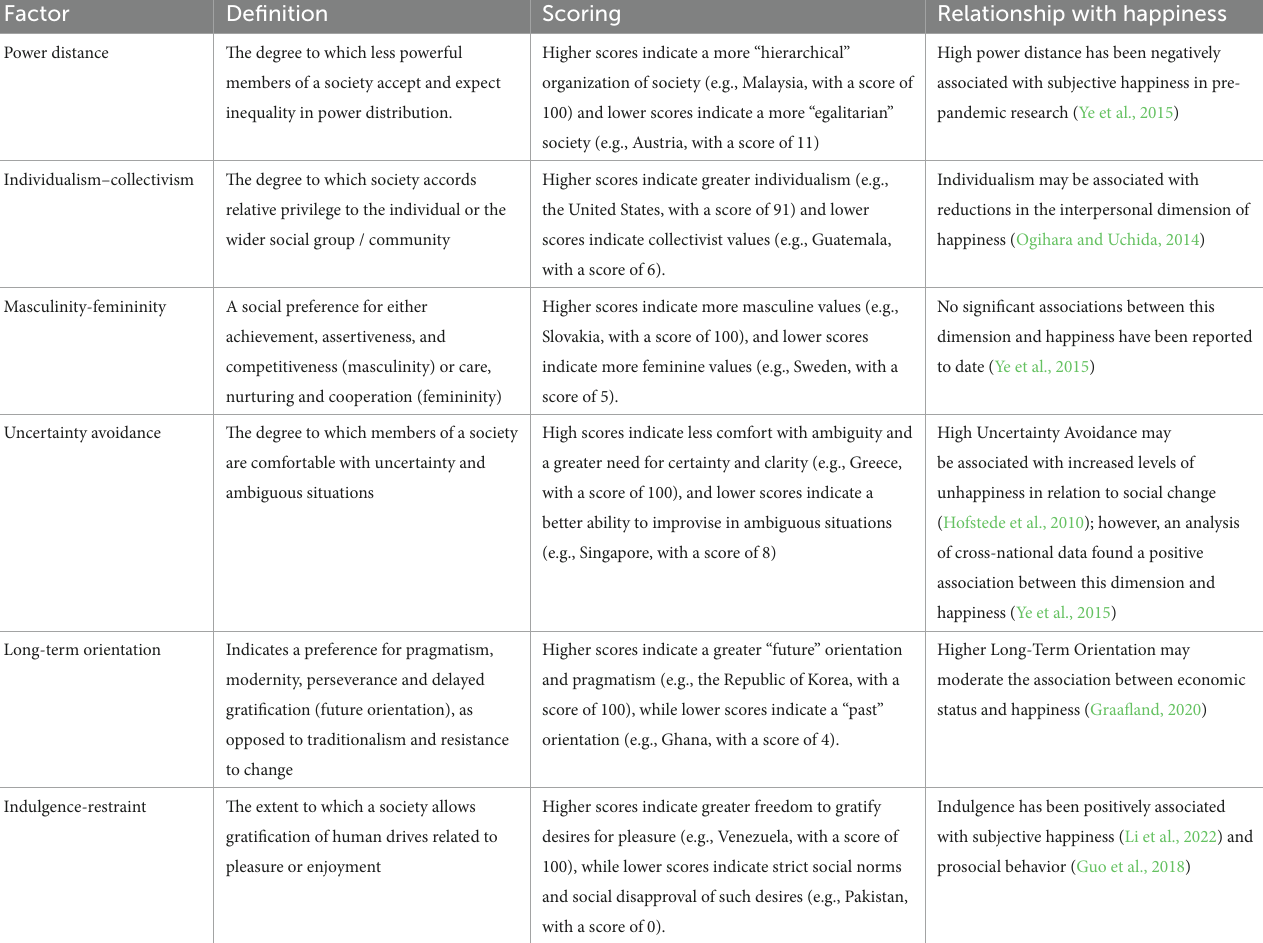
TABLE 1 Hofstede’s six-factor model of culture and its relationship to